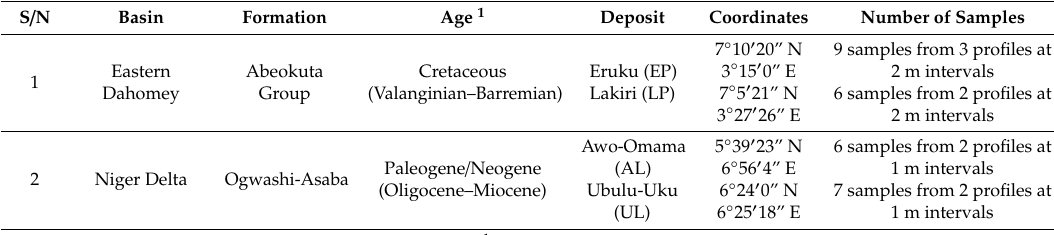
Figure 1. Geologic Maps of ( a ) Eastern Dahomey and ( b ) Niger Delta Basins showing the study areas (modified after [12,13]). Table 1. Summary details of the studied kaolin deposits.